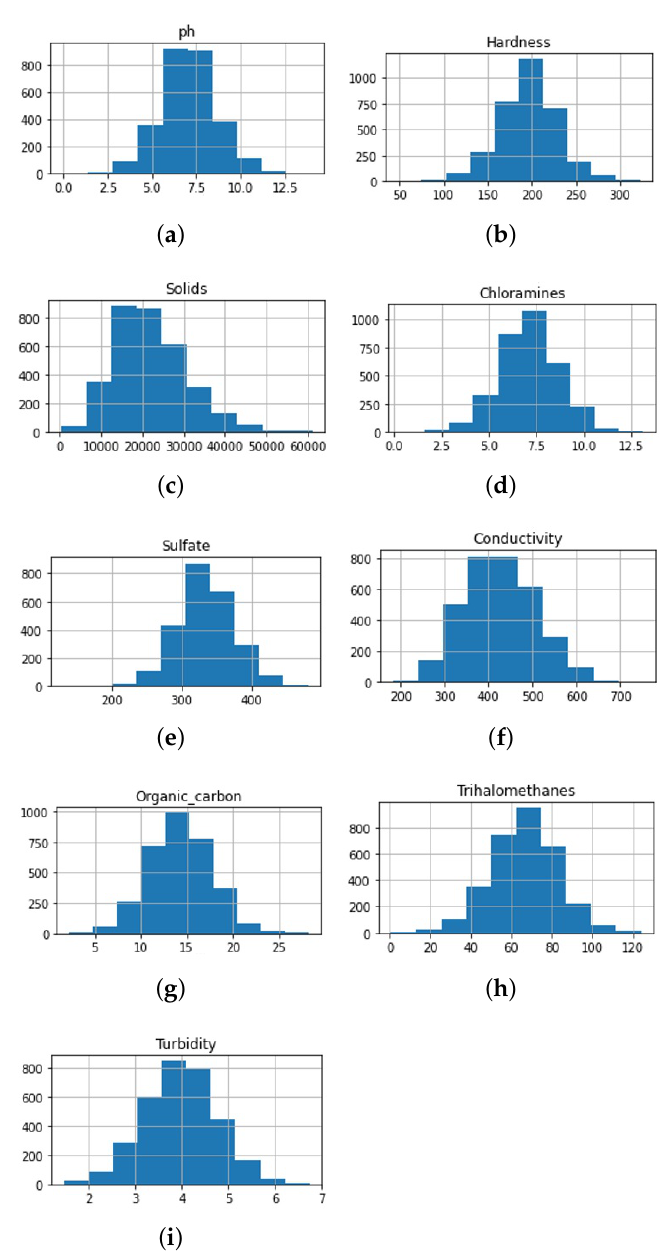
Figure 2. Class-wise histogram representation of each